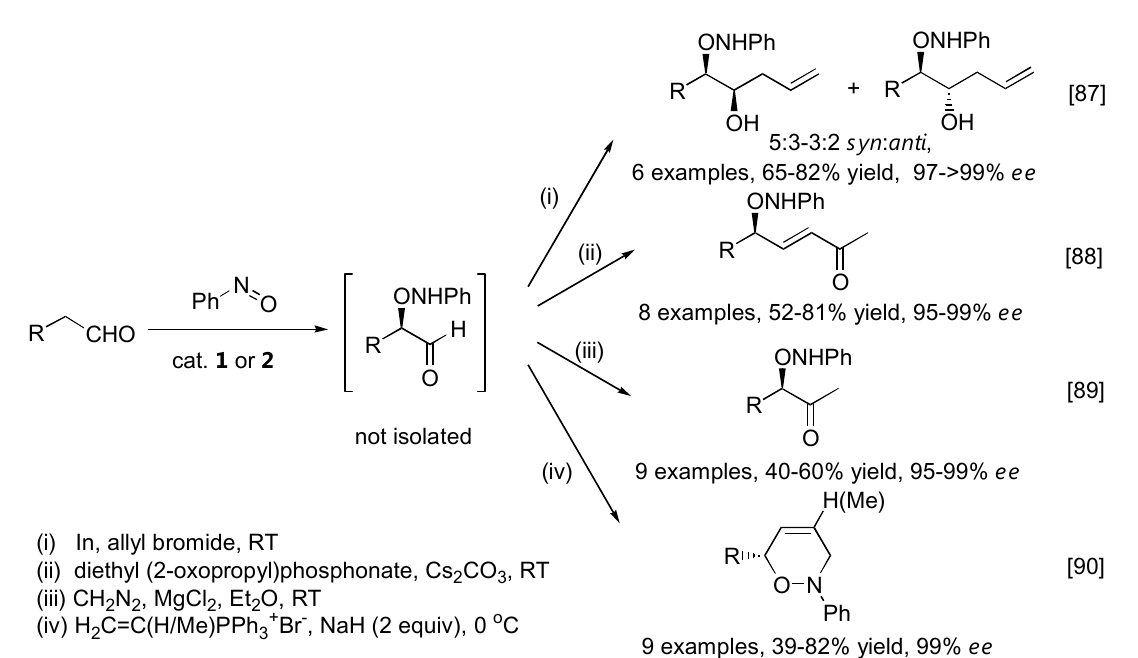
Figure 22. Transformation of aminoxylated aldehydes to other synthetically useful intermediates.